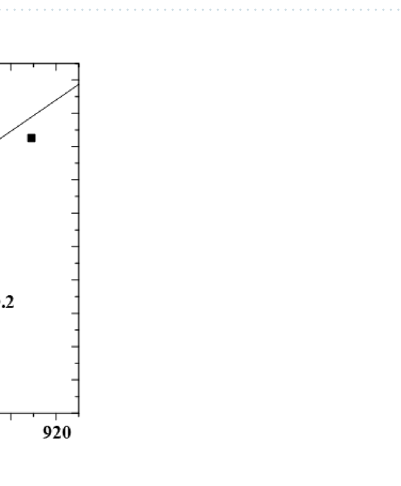
Figure 25. S–N curve for the shot peened and twisted OT wire.